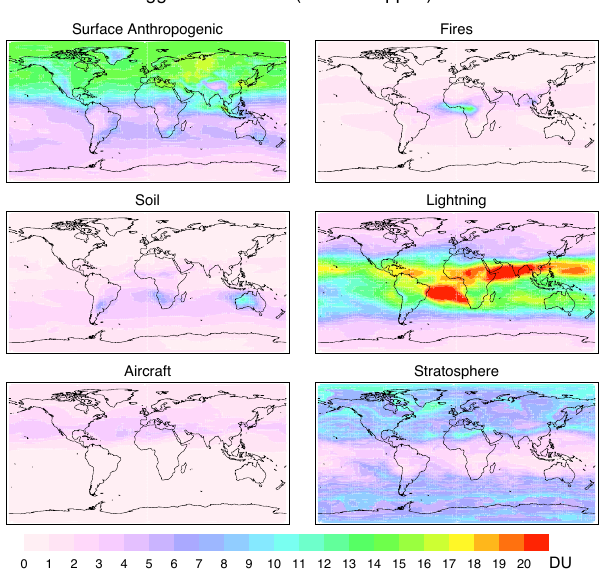
Fig. 3. As Fig. 2, for July